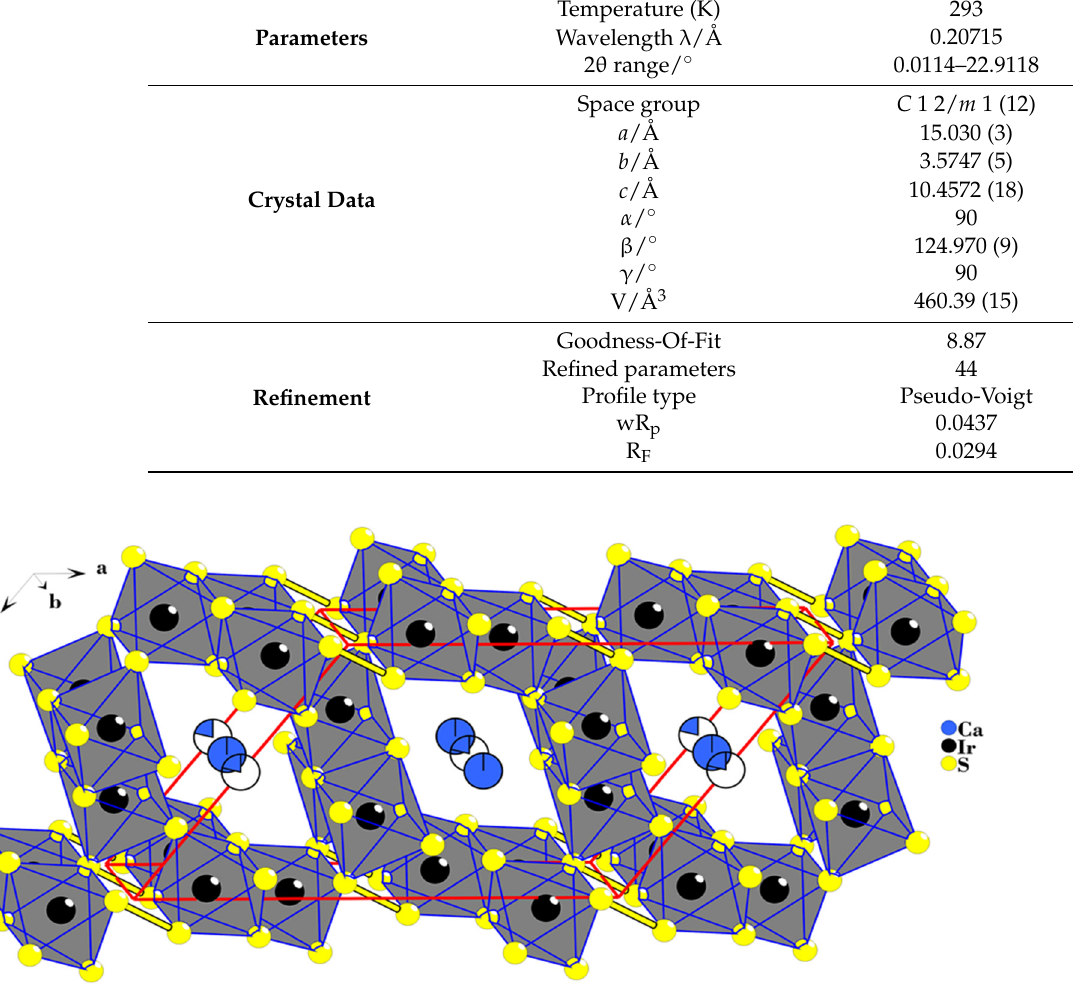
Figure 3. Crystal structure of CaIr 4 S 6 (S 2 ) viewed along the b-axis.